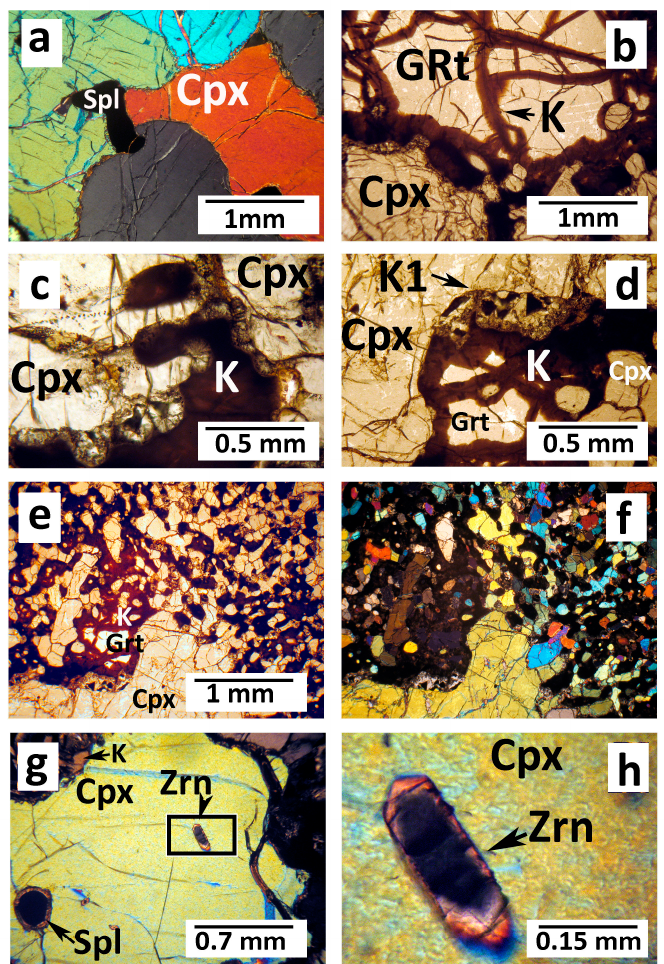
Figure 2. Microphotographs displaying details of sample thin sections under the optical microscope, in plane polarized transmitted light. ( a ) Geometric relationships between coarse clinopyroxene (Cpx) grains. Crossed polars. Spl = Al-spinel. ( b ) Coarse garnet grain (Grt) partially replaced by kelyphite (K). Plane pol. light. ( c ) Penetrative intergrowths between kelyphite, replacing former garnet and clinopyroxene. Plane pol. light. ( d ) Detail of a typical curvilinear contact between coarse clinopyroxene (Cpx) and garnet (Grt). The garnet is widely replaced by kelyphite. The arrows indicate a zone of the contact surface where the grain-size of the kelyphite is significantly increasing (K1). Plane polarized light. ( e ) Microphotograph (plane polarized light) showing the passage between the coarse- and fine-grained areas of the sample. The former is represented by a small portion of a coarse clinopyroxene grain (bottom side of the picture). The fine-grained area exhibits a poikyloblatic-like texture consisting of irregular garnet relicts, small round clinopyroxene and spinel grains immersed in the kelyphite (dark brown to black in color). ( f ) The same as in ( e ) viewed under crossed polars. ( g ) A clinopyroxene grain enclosing a tiny, euhedral zircon grain (Zrn). Plane polarized light, crossed polars. ( h ) Magnification of the rectangular inset in the previous picture highlighting the zircon grain. More explanation is given in the